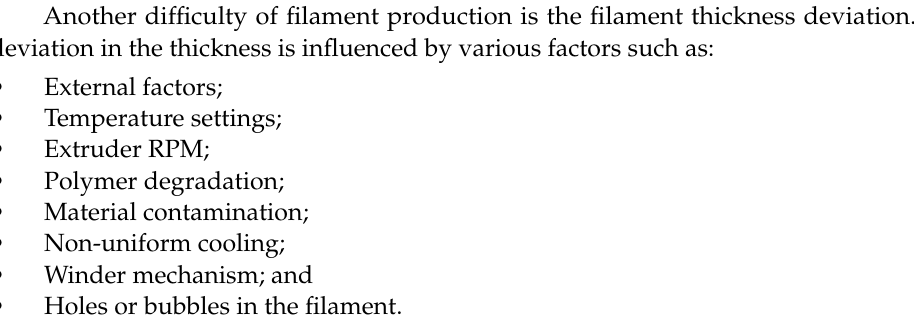
Figure 10. Top: Microscopic image of unmelted polymer for base matrix materials A and B. Bottom: Photos of unmelted granules while filament